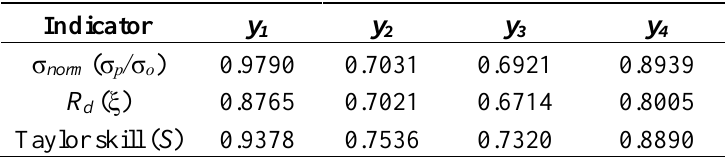
Table 10. The association coefficient of each data